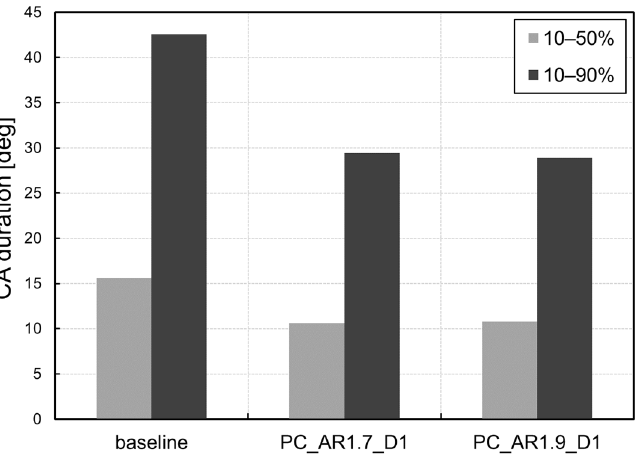
Figure 12. Duration of combustion phase: comparison between standard engine and engine equipped with two pre-chambers with different aspect ratio.